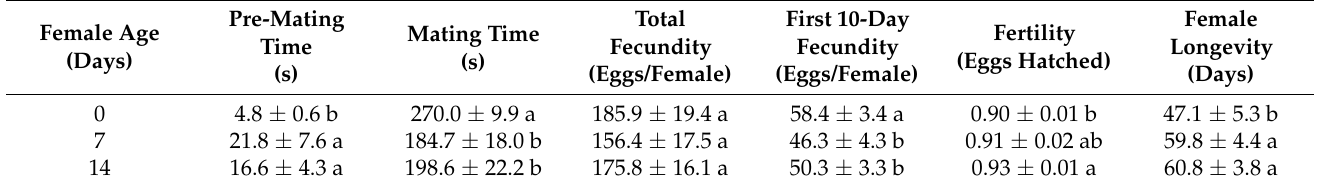
Table 2. Effect of female age at mating on mating time, fecundity, fertility and longevity of Orius laevigatus